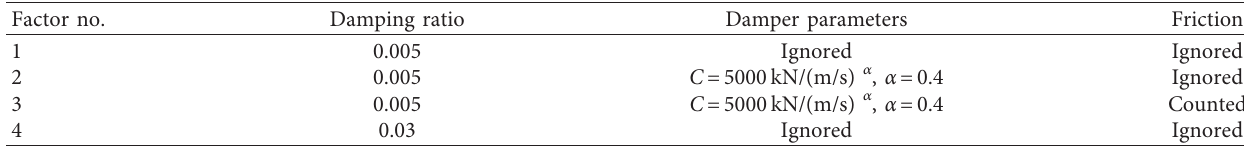
Figure 15: DAFs for longitudinal displacement at the end of the girder under a single moving load. Table 4: Cases for calculation of different damping conditions.